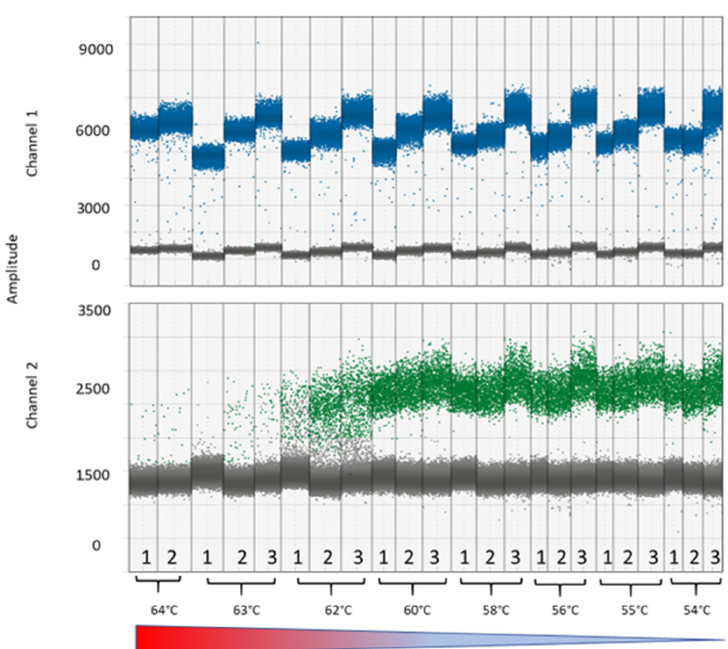
Figure 3. Thermal gradient PCR for optimizing the annealing temperature with temperatures ranging from 64 °C to 54 °C. Gradients were used for the giant virus and virophage primers and probes (technical replicates n = 3, one technical replicate was lost for temperature 64 °C).